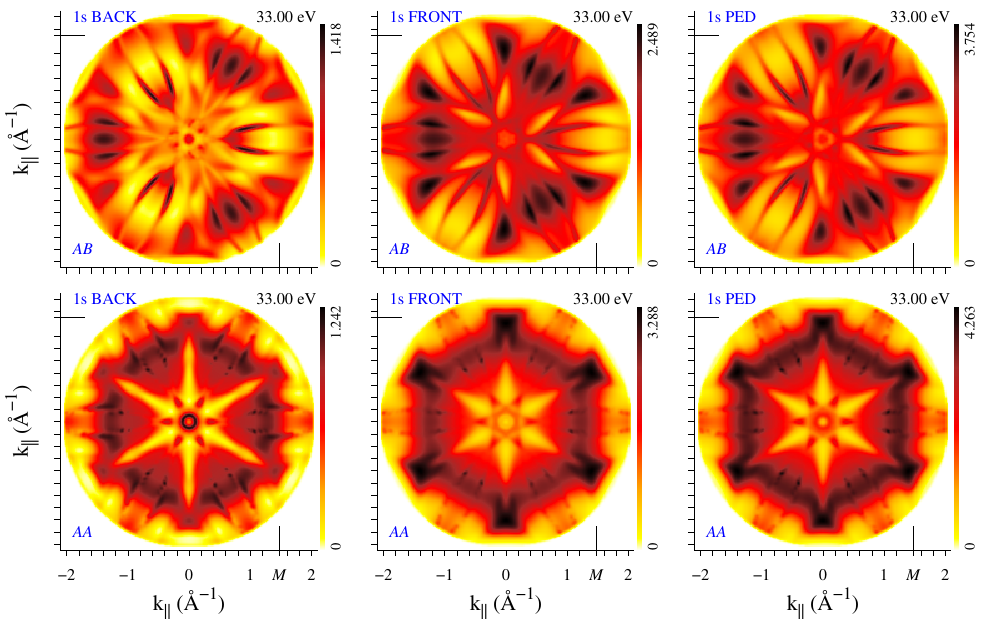
Figure 4. Photoelectron diffraction at 33 eV from the bilayer graphene with AB ( upper row ) and AA stacking ( lower row ). Left to right: initial 1 s states at the back layer, at the front layer, and the true full-bilayer states. Full movies are at film3-ABBFT.mov for AB and film4-AABFT.mov for AA stacking.